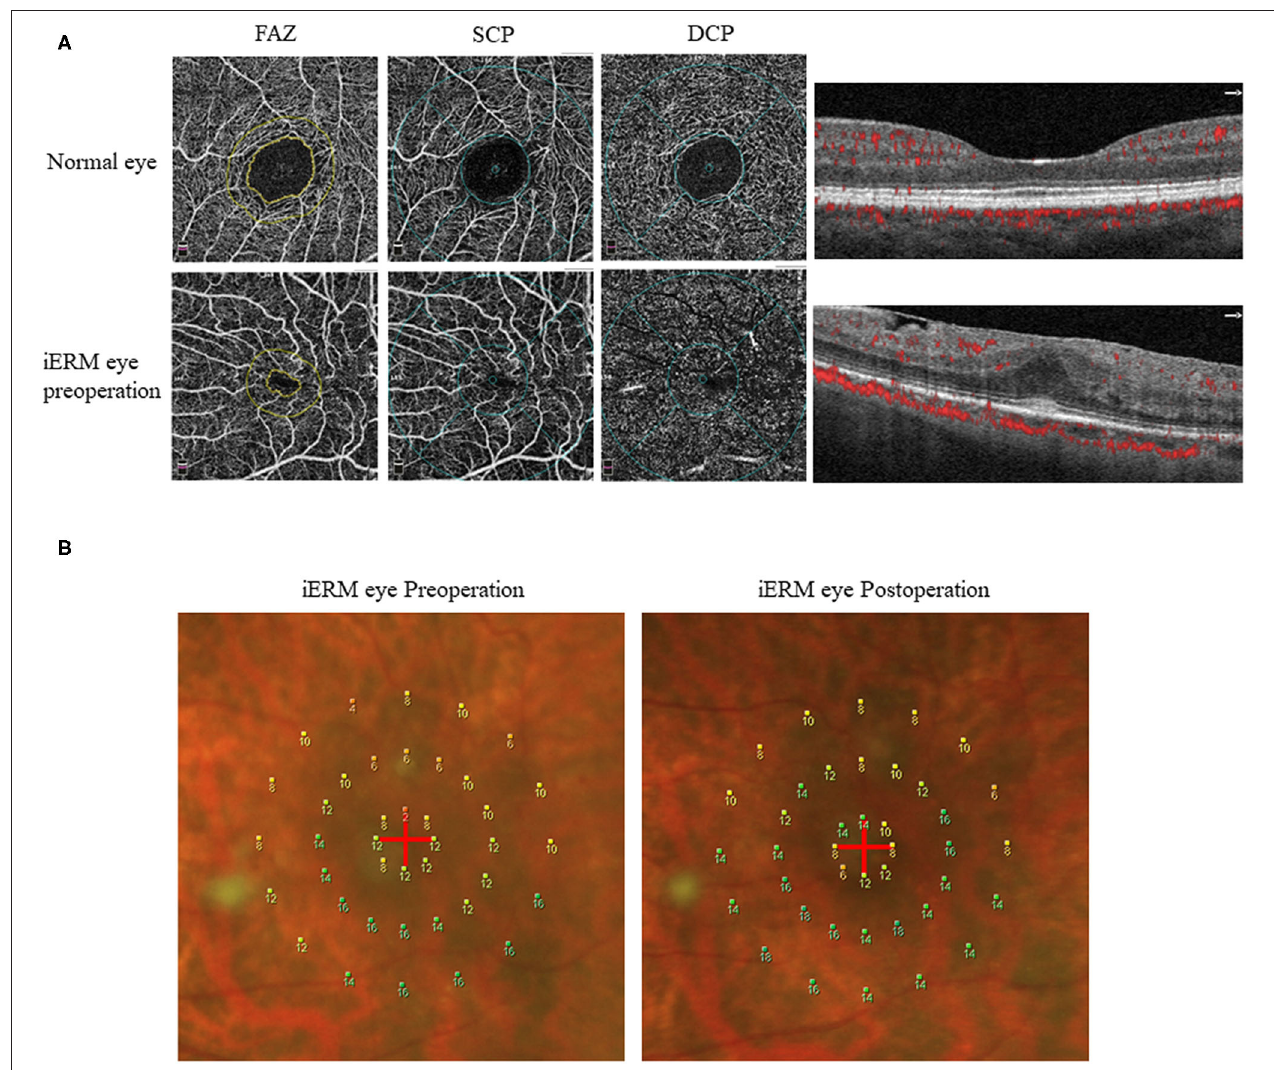
FIGURE 1 | Representative OCTA and microperimetry images. (A) OCTA images of a 63-year-old female with iERM (lower row) compared with the normal eye (upper row). (B) The microperimetry results from this patient by MP-1 examination before and 3 months after surgery showed